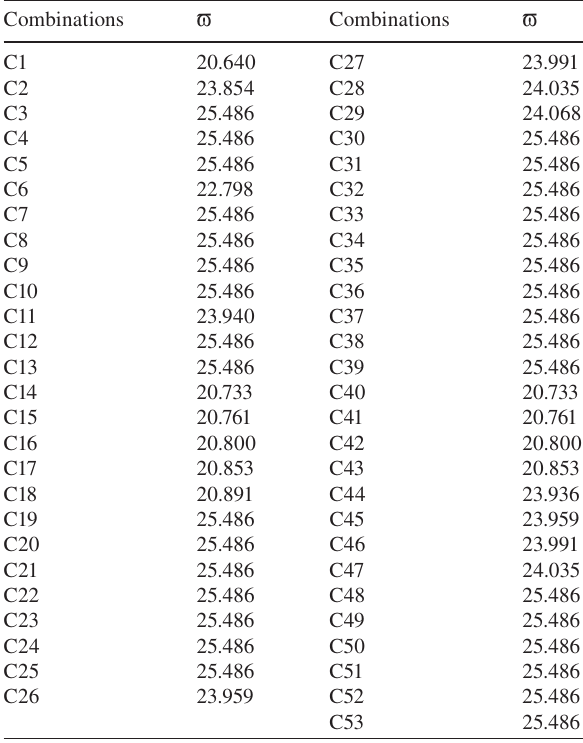
Table 6 Fundamental frequency parameter for laminated plates with intermediate line supports for ( CFCF ) boundary condition.